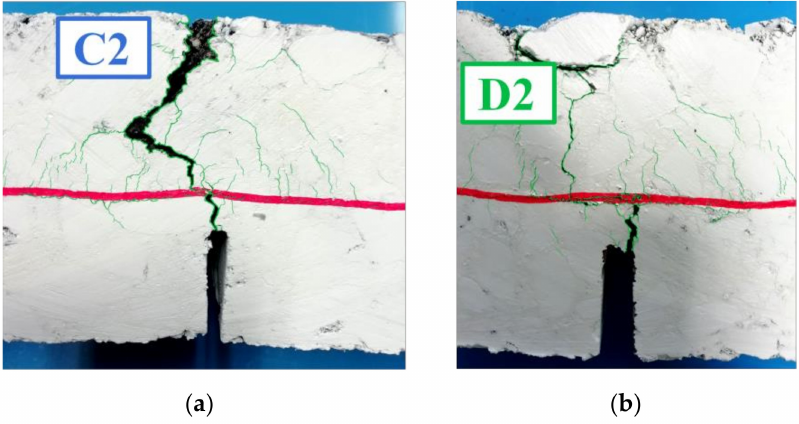
Figure 14. Failure mechanism observed for the specimens with geocomposite C ( a ) and D ( b